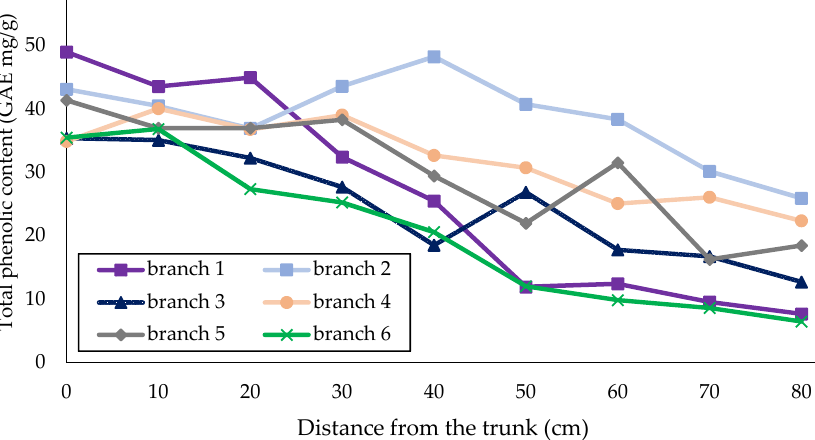
Figure 1. Total phenolic content of six branches determined with FC reagent.